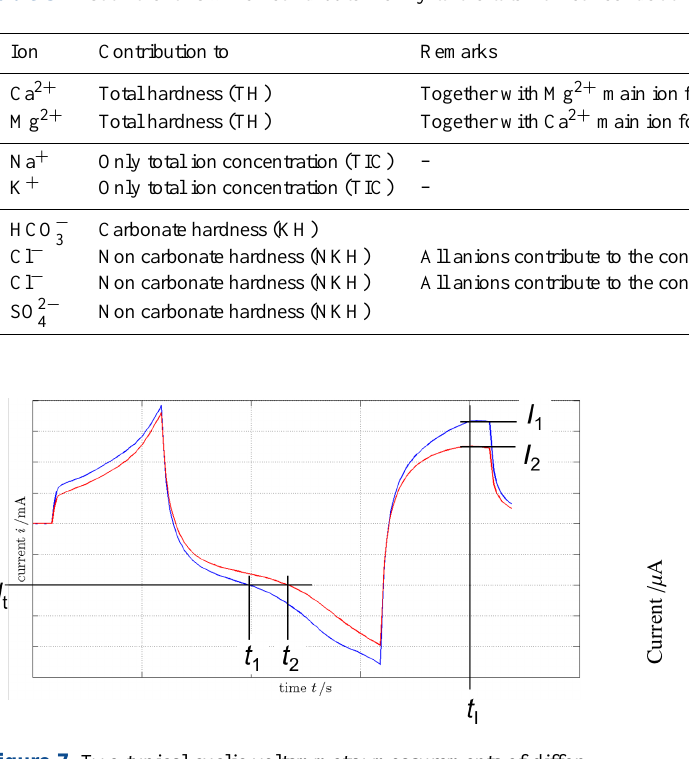
Table 3. List of the ions which contribute mainly to the total ion concentration of water.